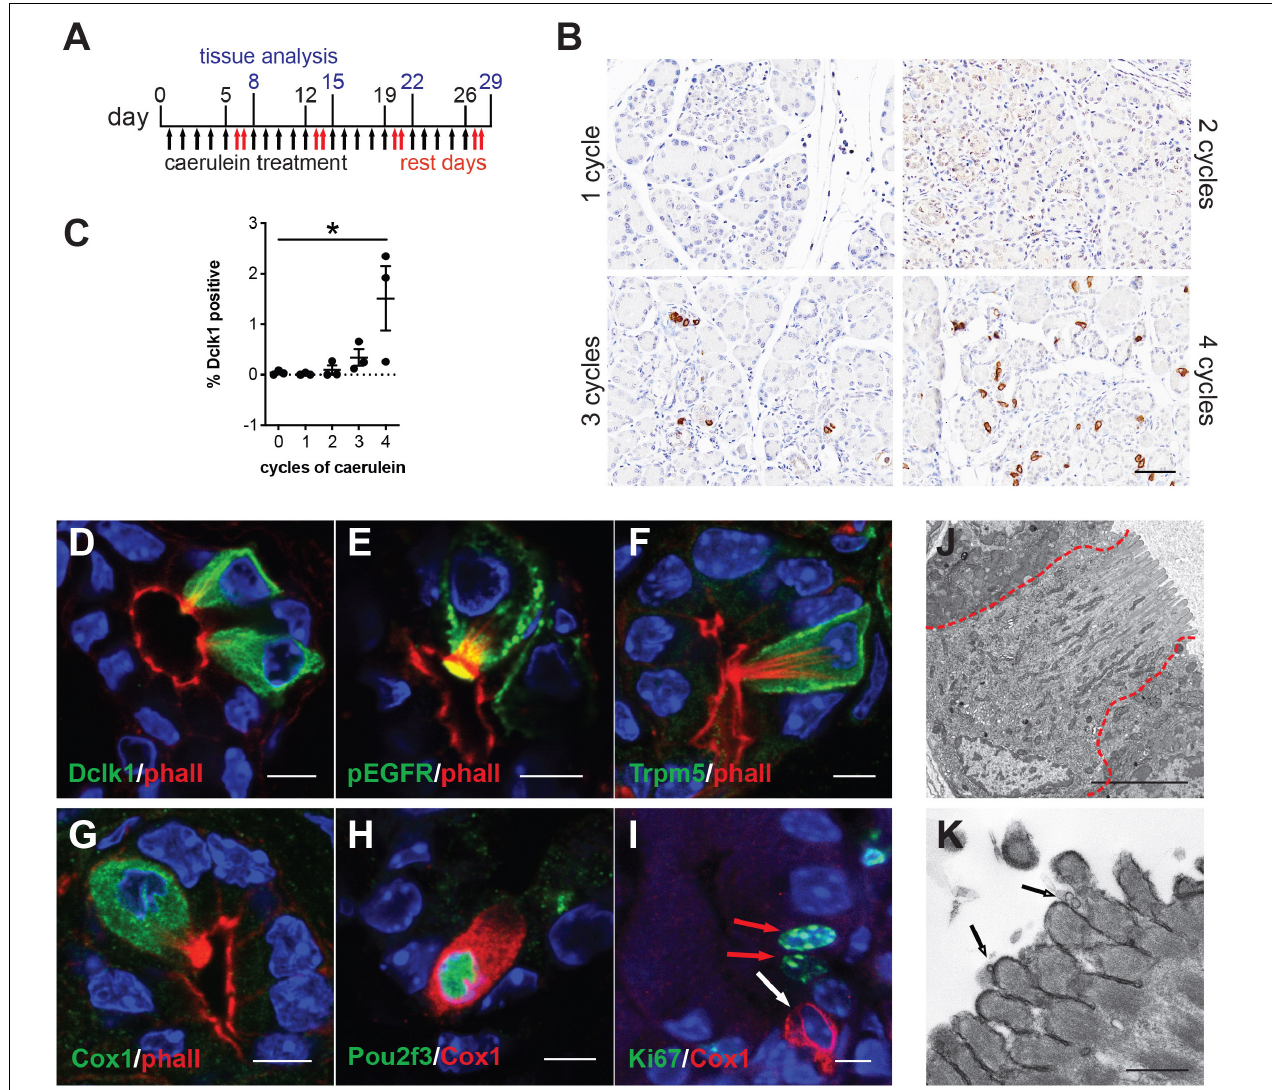
FIGURE 1 | Chronic injury induces tuft cell formation in the pancreata of wild type mice. (A) Schematic of caerulein treatment for pancreatitis induction in wild type mice. (B) Immunohistochemistry (IHC) demonstrating an increase in Dclk1 expression (brown) in the injured pancreas over time and quantified in (C) ( n = 3 mice per condition). Scale bar, 50 µ m. (D) Co-immunofluorescence (Co-IF) for tuft cell marker phalloidin (red, labels the microvilli and actin rootlets of tuft cells) and Dclk1, (E) phospho-EGFR, (F) Trpm5, or (G) Cox1 (green). (H) Co-IF for tuft cell marker Cox1 (red) and Pou2f3 or (I) Ki67 (green). Red arrows, Ki67 + nuclei, white arrow, Ki67- tuft cell. Scale bars, 5 µ m. (J) Electron microscopy confirming tuft cell formation in pancreatitis, and (K) demonstrating the presence of vesicles at the tips of the microvilli (arrows). Scale bars, 5 µ m and 500 nm,